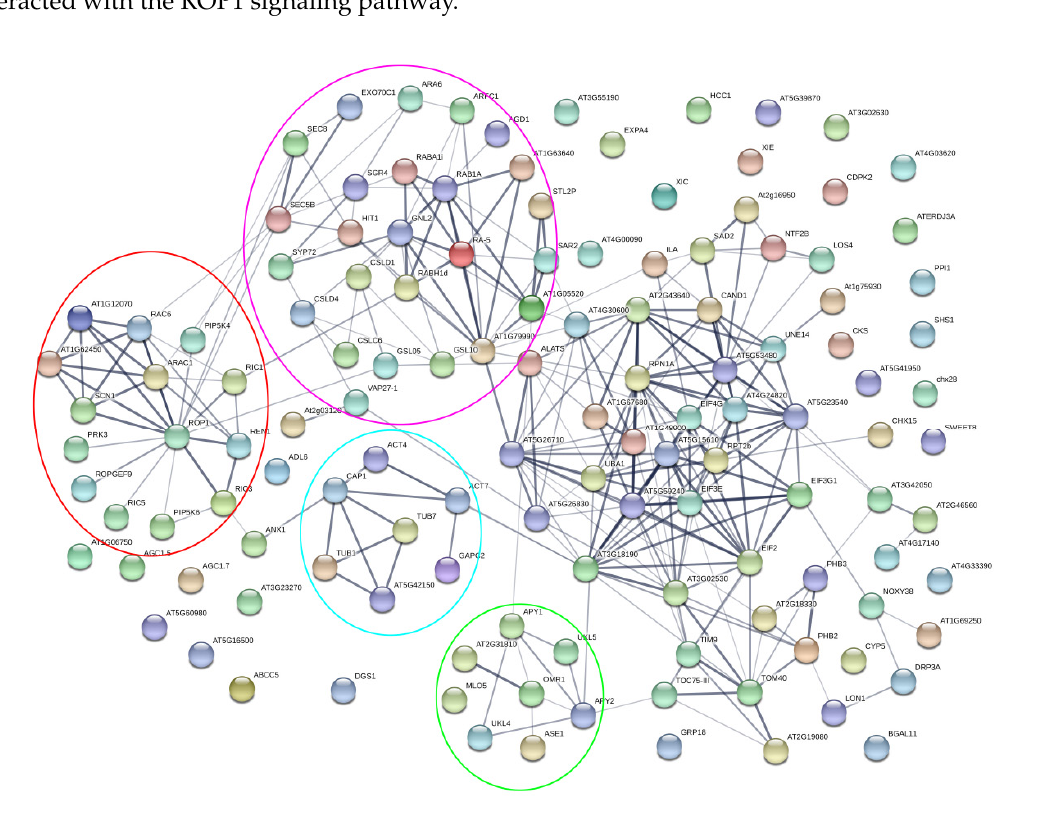
Figure 5. A putative network was assembled among 130 ROP1-associated proteins. The 130 proteins included members of multi-organism reproductive processes, pollen tube growth, plant-type cell wall modification, cytoskeleton organization, and intracellular transport based on the classification of biological processes.